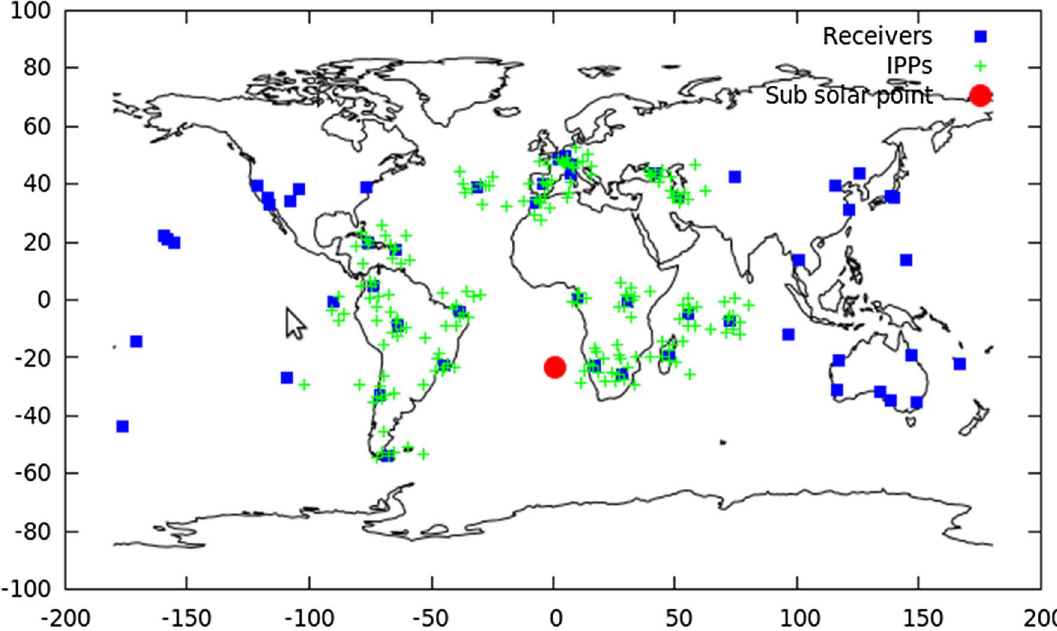
Fig. 2. An example of the network of IGS – GNSS receivers (blue squares) and the IPPs (green crosses). The SSP is also indicated with a red circle. The example corresponds to DoY 365 in 2009 at 12.